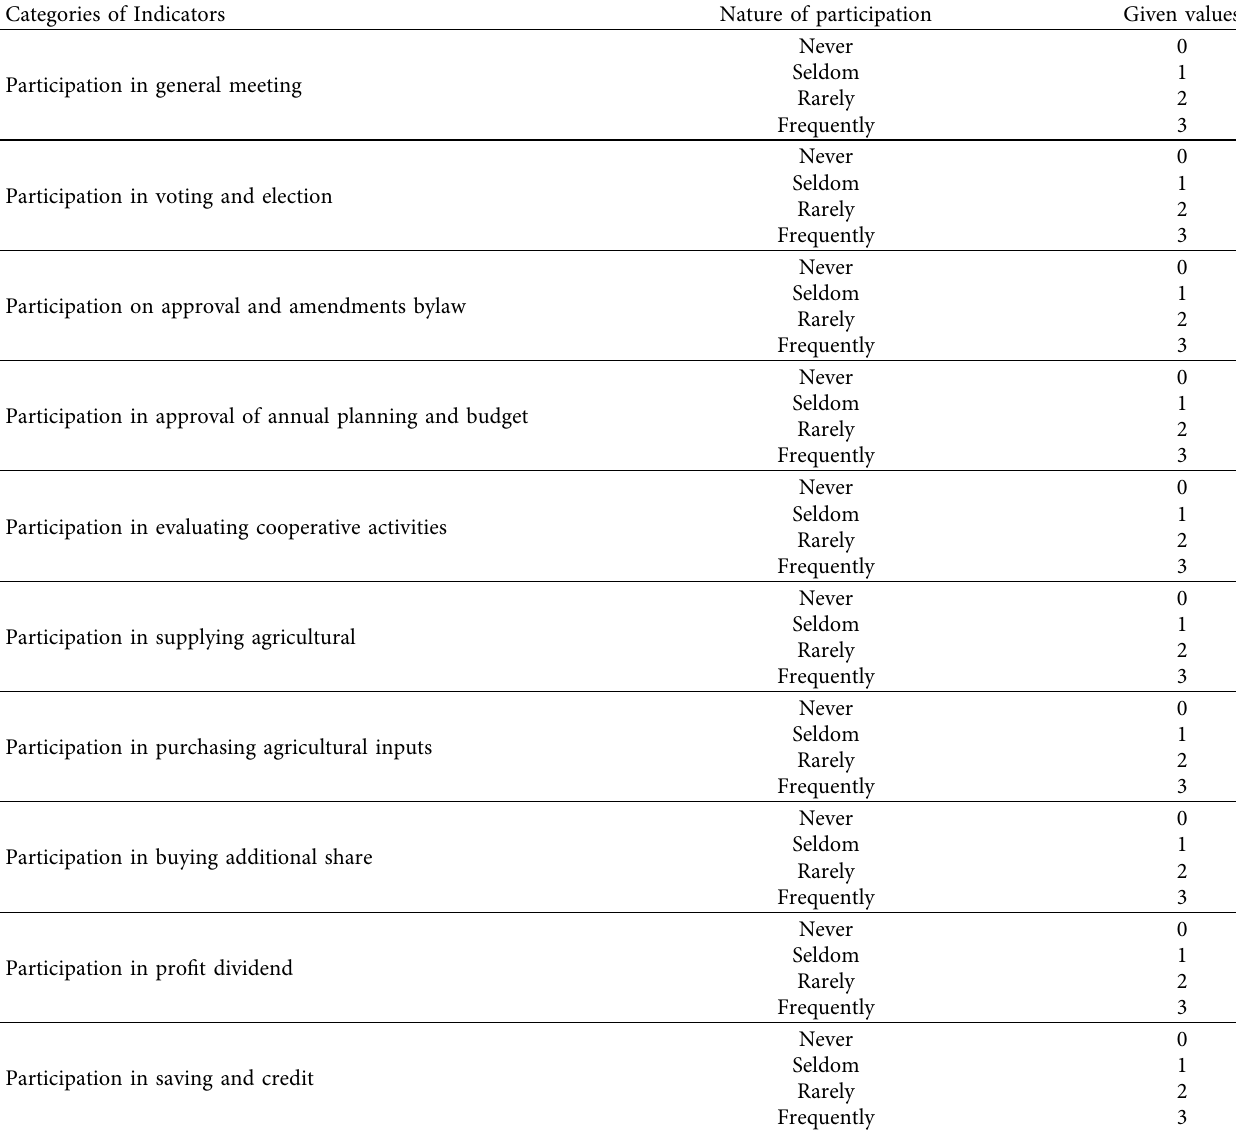
Table 4: Membership participation and values for indicator activities